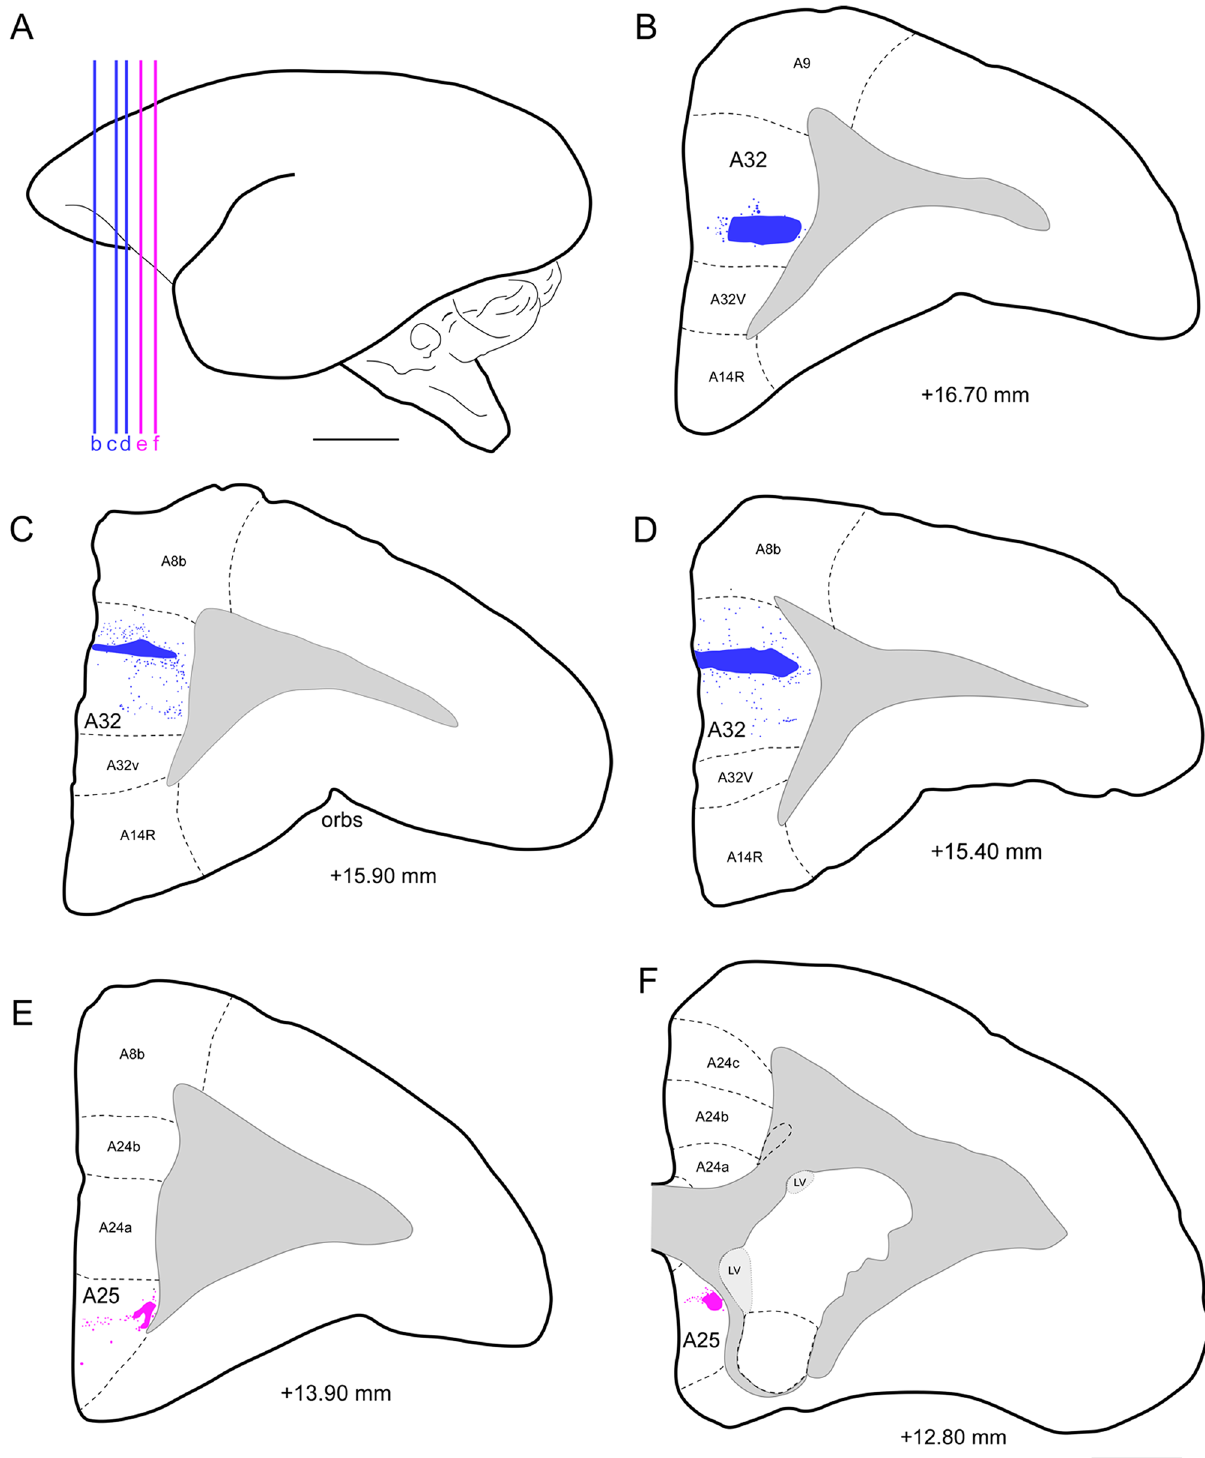
Figure 1. Injection centers and the location of the interaural levels (IA). ( A ) Interaural levels of the five cases in view A-P (marked with color lines); ( B ) (case 5), ( C ) (case 2), ( D ) (case 1): injections in A32 (blue); ( E ) (case 3) and ( F ) (case 4): injections in A25 (purple); IA level location based on the atlas “The marmoset brain in stereotaxic coordinates”); Scale bar ( A ) 5 mm; ( B – F ) 1000 µm. The figure was drawn in Canvas software version 12.0 76